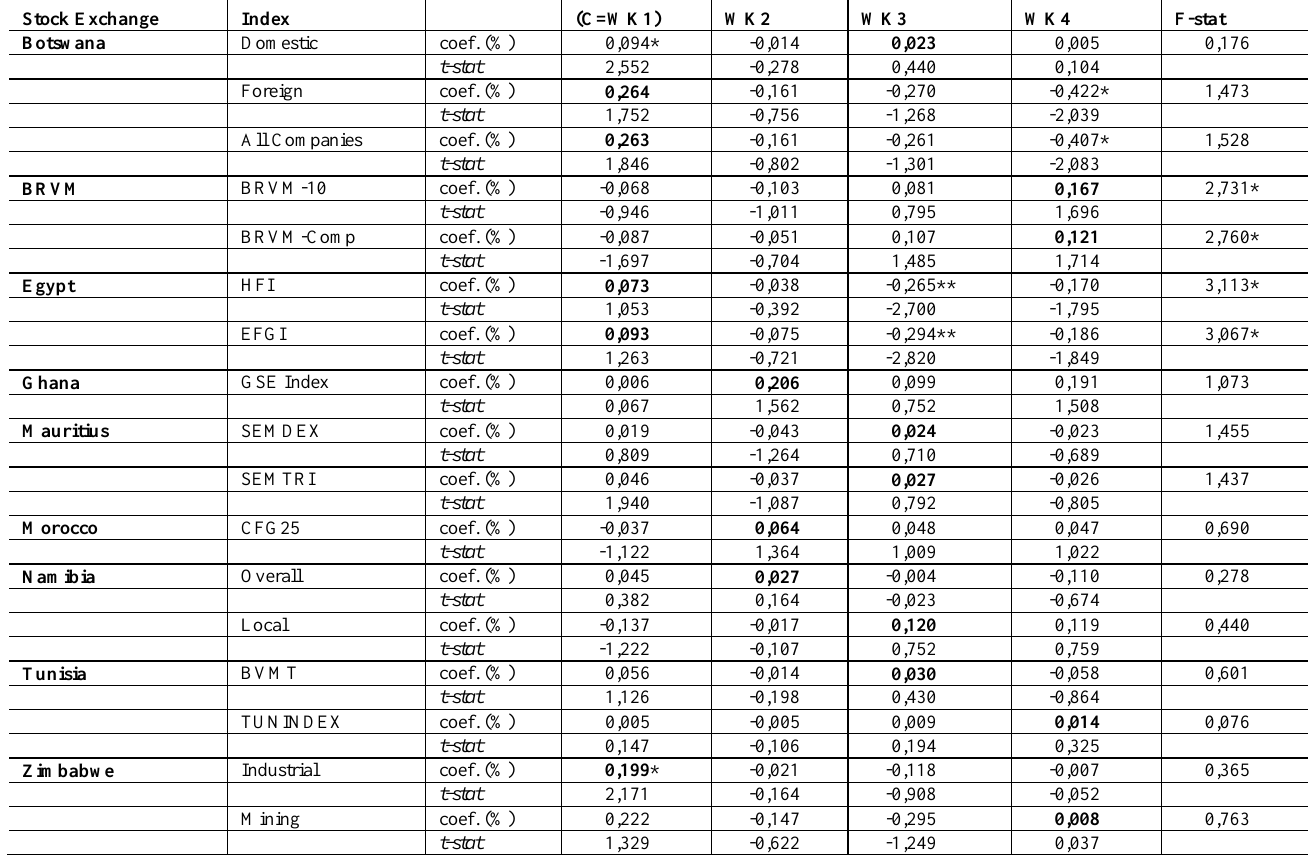
Table 6: Regression Results for Week-of-the-Month Effect Stock